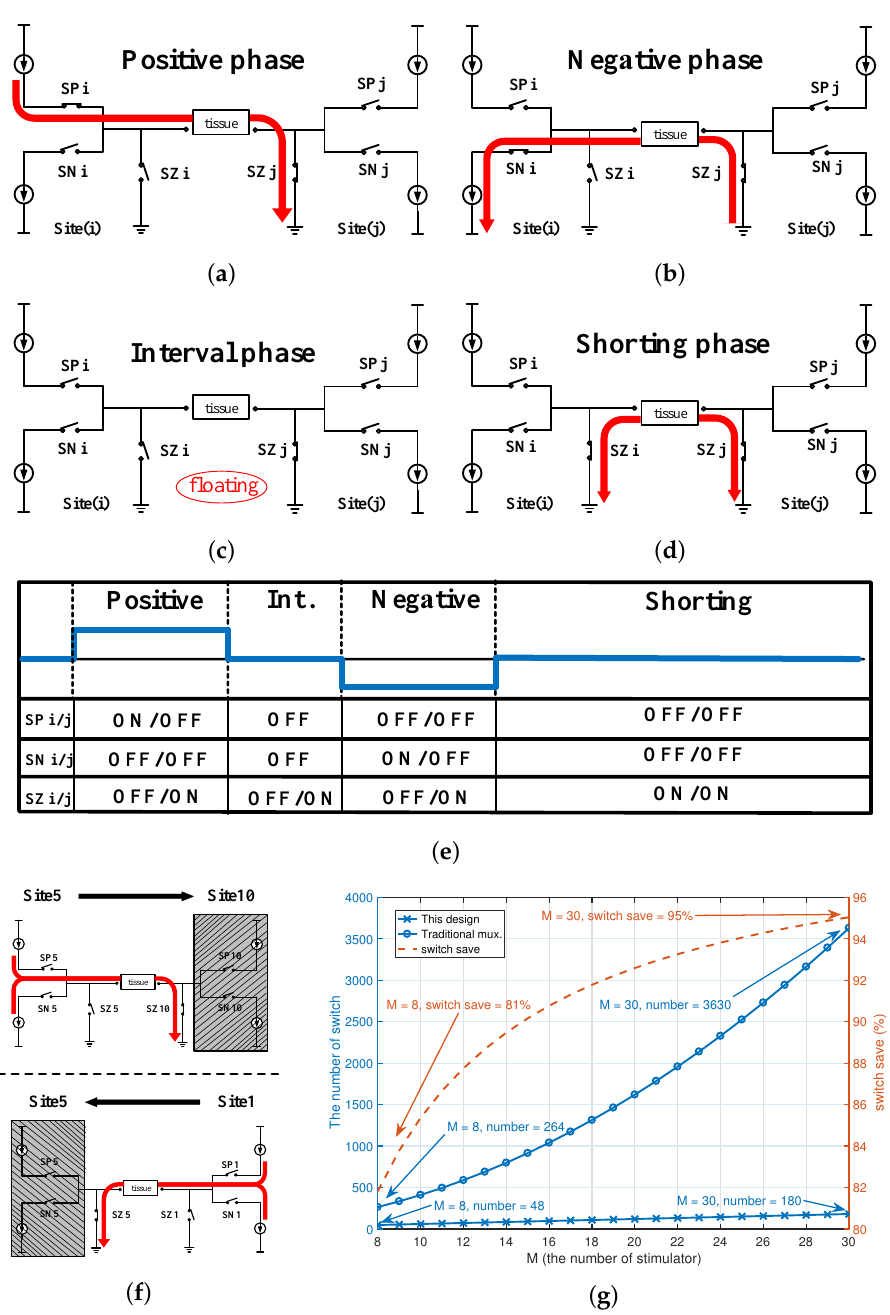
Figure 4. Architecture of the proposed switch array. There are three switches in each site, SP, SN and SZ. Four different phases, the ( a ) positive phase, ( b ) negative phase, ( c ) interval phase and ( d ) shorting phase can be realized by switching on/off the transistors in a pair of sites; ( e ) the configuration of the switches for different phases; ( f ) an example of the arbitrary switch array; ( g ) comparison between the total number of switches required in the traditional method (marked in circle) and the proposed one (marked with a cross), as well as the percentage of switches saved by the proposed method (dash line in red). Int. is the interval in Figure